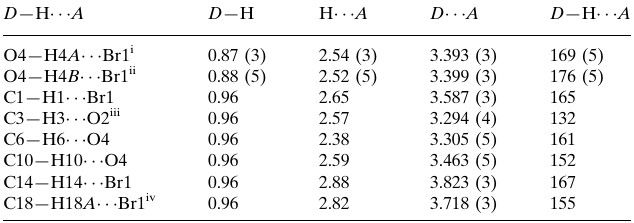
Data collection Mercury CCD diffractometer Absorption correction: multi-scan ( REQAB ; Jacobson, 1998) T min = 0.514, T max = 0.673